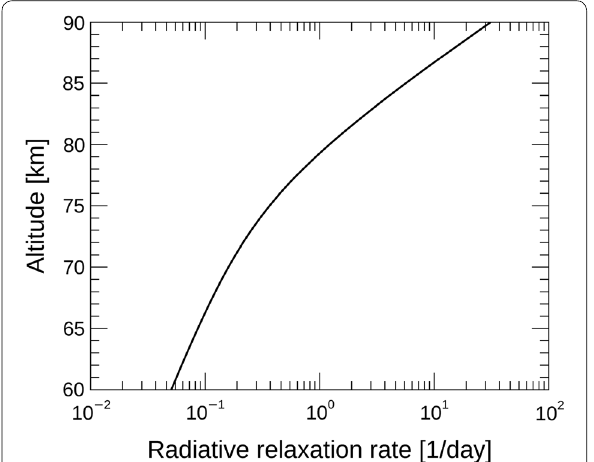
Fig. 3 Radiative relaxation rate as a function of altitude